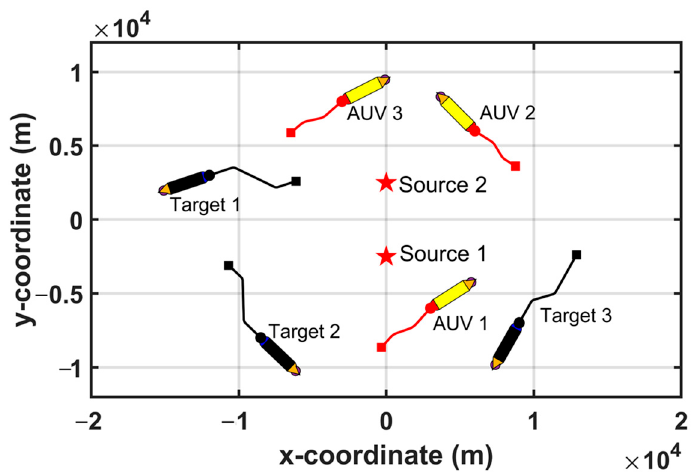
Figure 5. Underwater multi-static MTT scenario with two sources, three AUVs, and three targets. Solid circles represent the starting points, and solid squares represent the ending points. The five stars represent the sound sources. The solid lines represent the trajectories of the AUVs and targets.